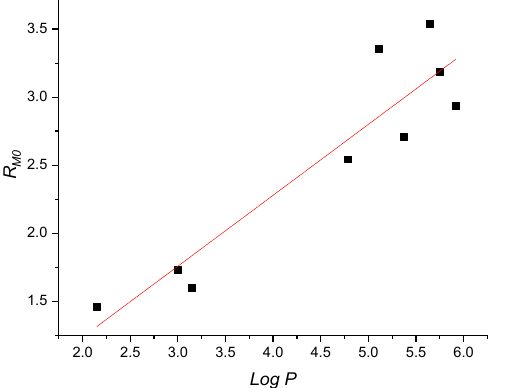
Figure 4. Correlation between experimental ( R M 0 ) and computed lipophilicity ( log P ).